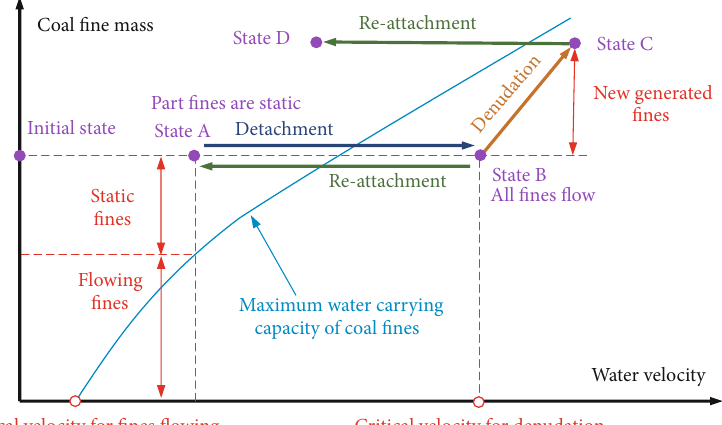
Figure 2: Schematic of the entire fl ow process of coal fi nes.